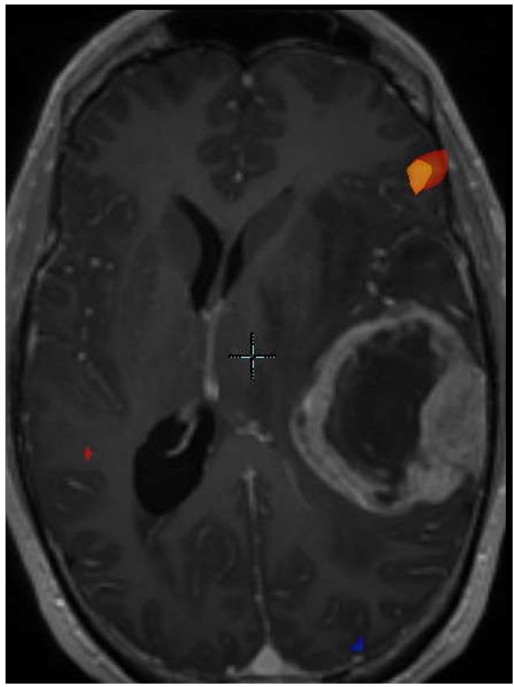
Figure 2. Functional MRI BOLD map superimposed on an MRI of an epithelioid GBM. Note the large cystic component.